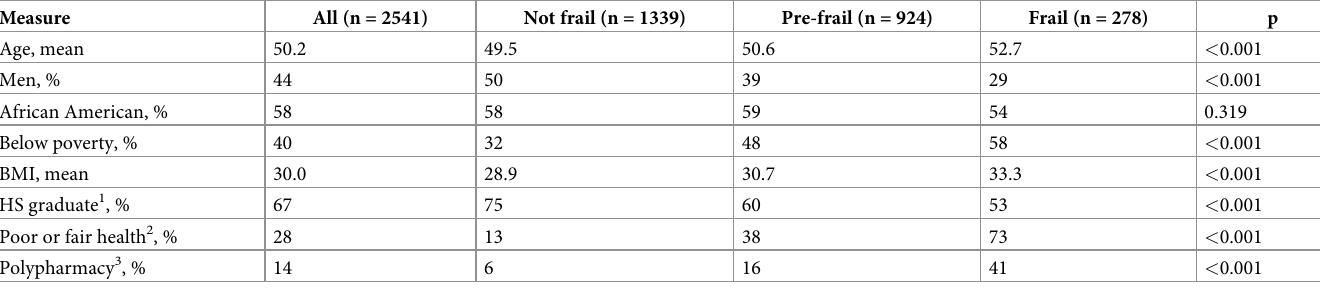
Table 1. Distribution of demographic variables and health measures by frailty status.